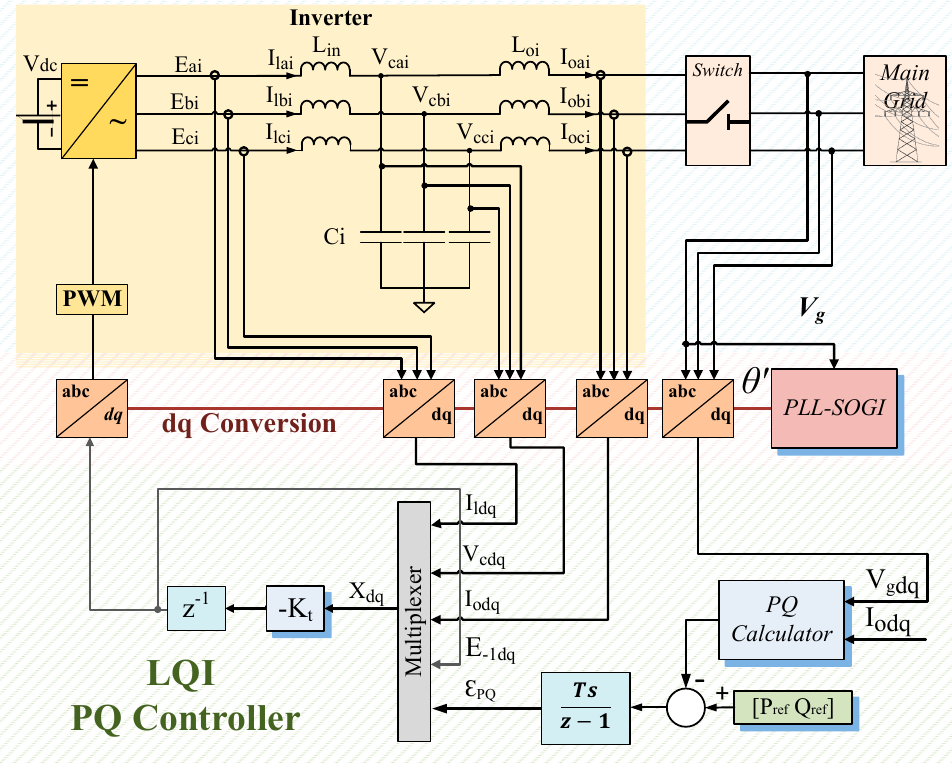
18 of 30 Figure 16. Singular values diagram for G μG (z) and its variations.